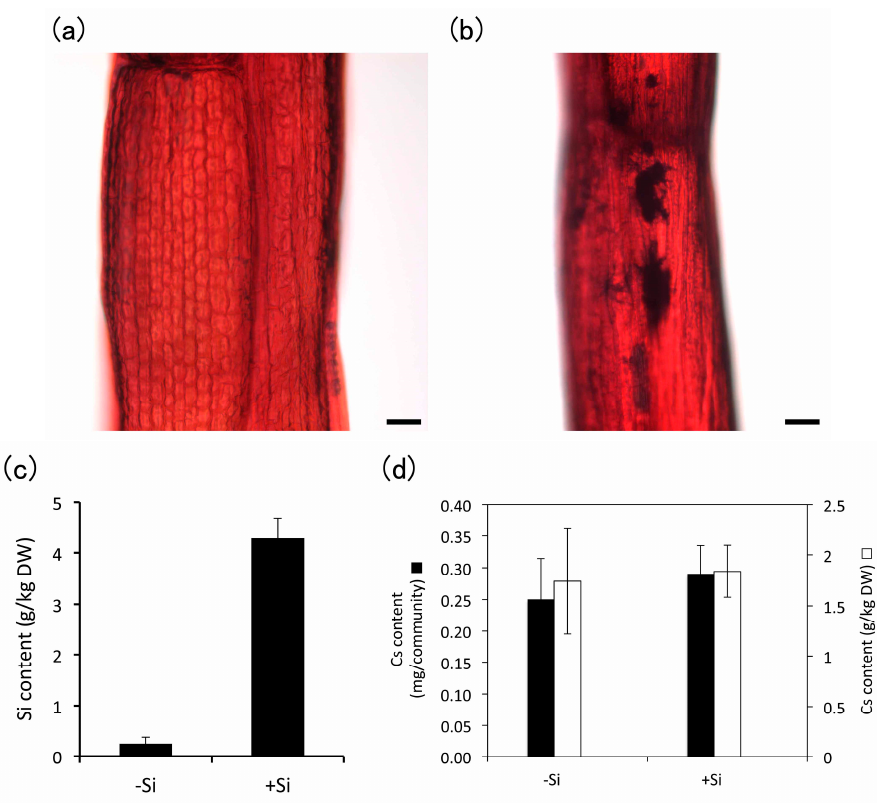
Figure 6. Staining of phytoliths in E. acicularis without ( a ) or with ( b ) 1 mM Si during subculture. Bar = 50 µm. ( c ) The determination of Si contents in E. acicularis subcultured with or without 1 mM Si ( n = 3, Bar, SE). ( d ) Accumulation of Cs in plant communities incubated in 4.8 mg/L Cs solutions ( n = 3, Bar, SE). Plant communities were subcultured with or without 1 mM Si and used for the experiment of Cs accumulation. Contents of Cs were determined with atomic absorption photometer. ( c , d ) These results were representatives of two experiments.